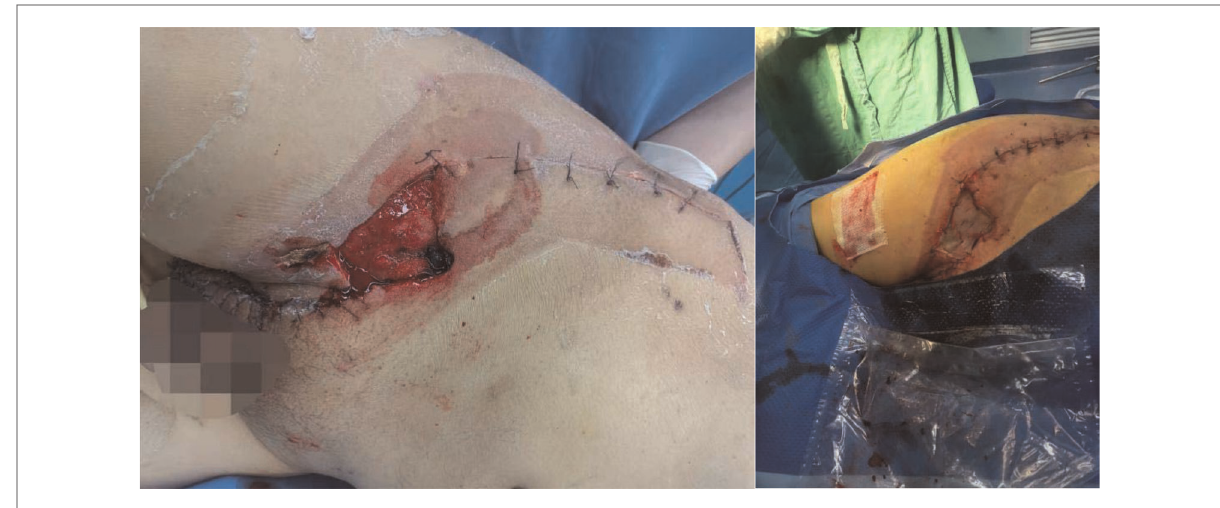
FIGURE 5 Four operations to remove VSD (left); suture and skin grafting (right).